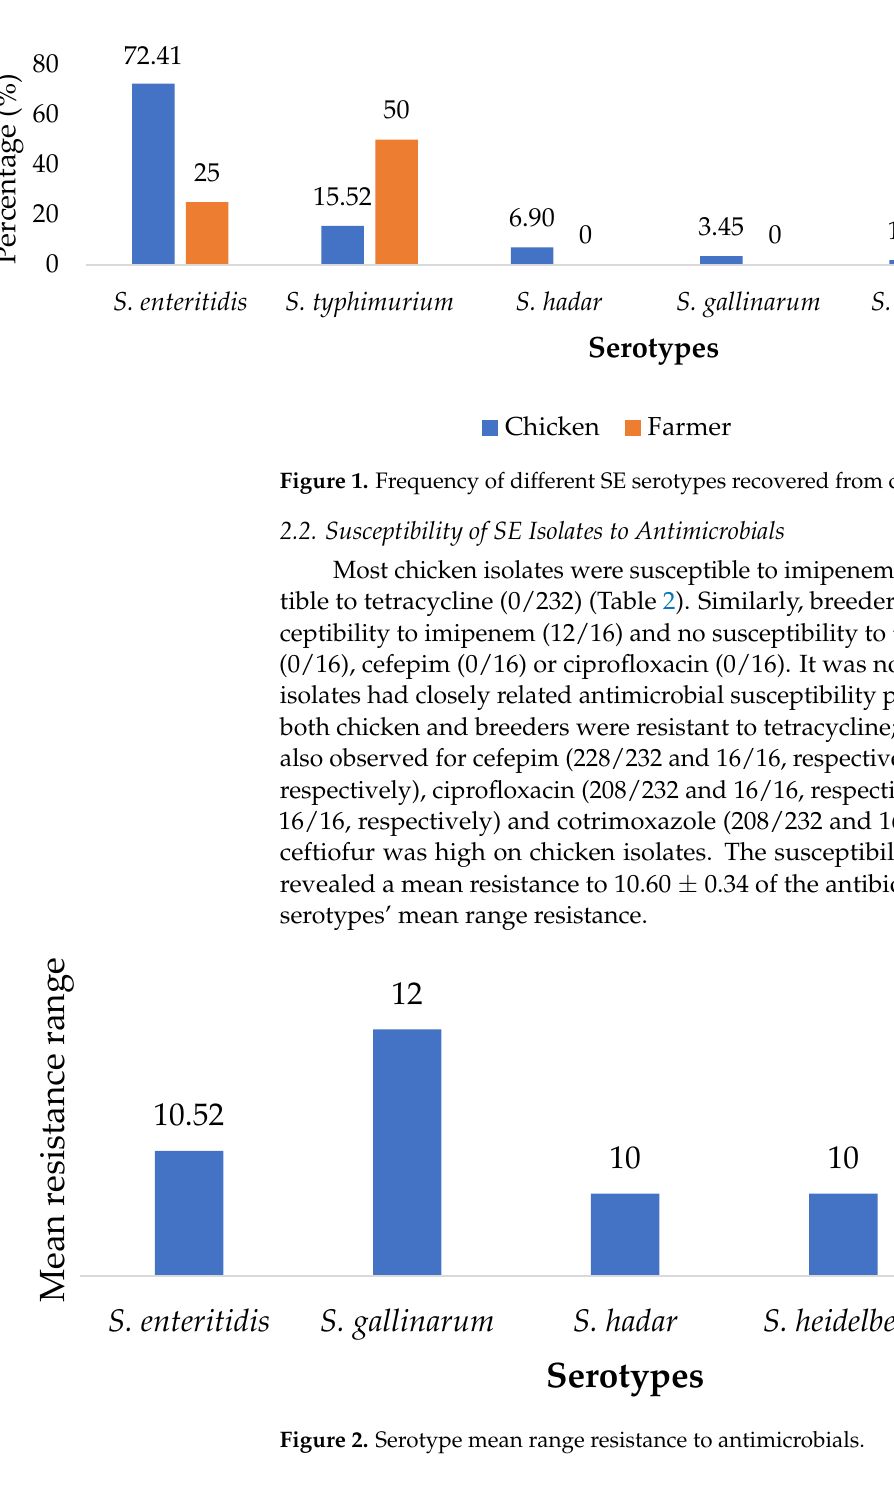
Figure 2. Serotype mean range resistance to antimicrobials .